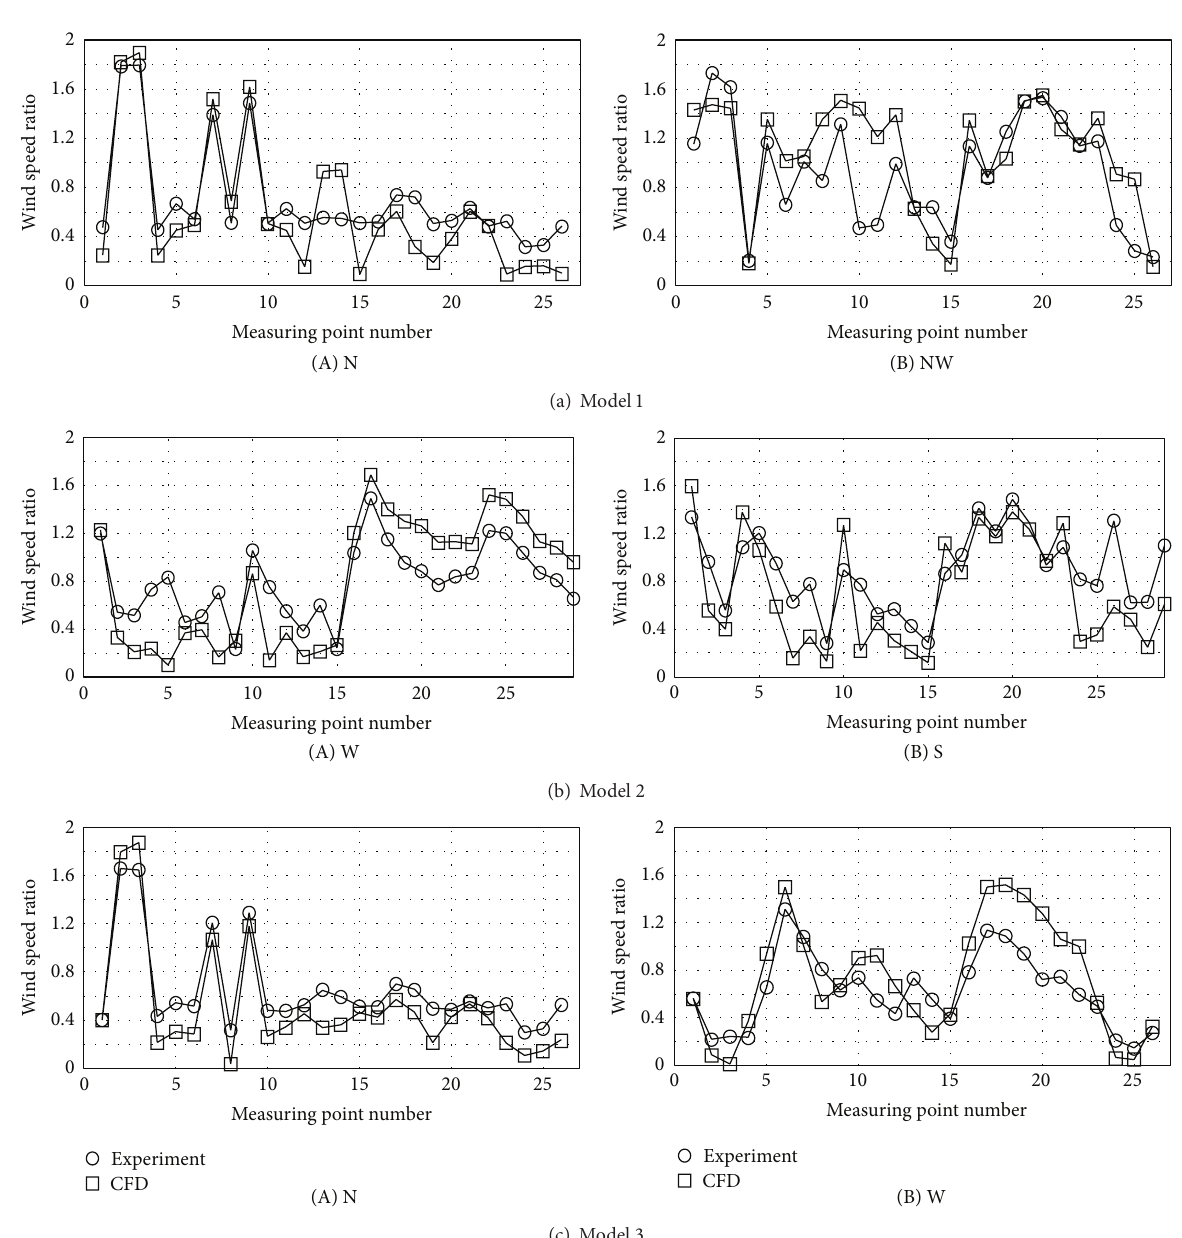
Figure 7: Comparison between the wind tunnel experiment and the CFD wind speed ratios at each measurement